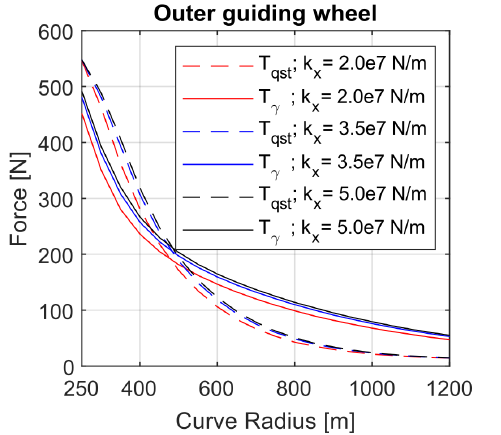
Figure 11. Dependence of the Y radius R for defined values of the bogie wheelbase 2 a .